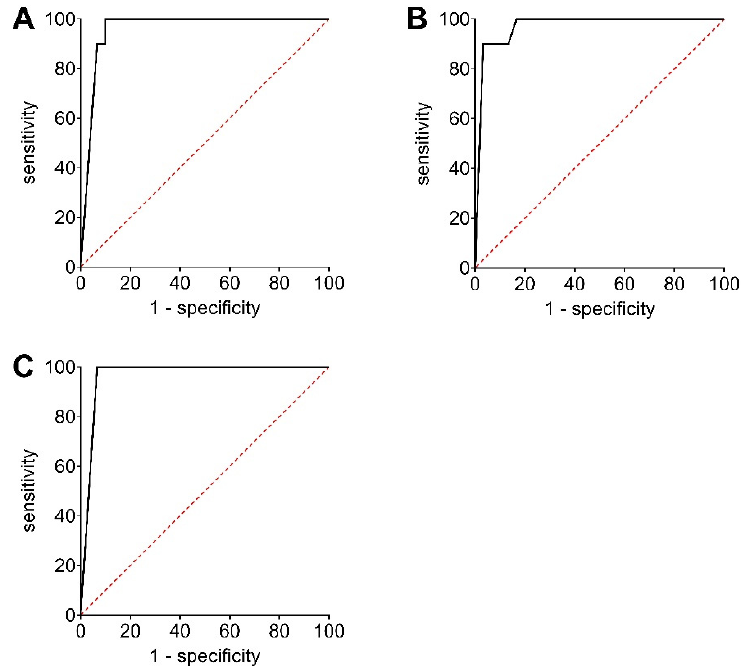
Figure 1. Receiver operating curve (ROC) analyses illustrating the relation of sensitivity and 1-specificity of CDV-Mix 3 ( A ), CDV-Mix 7 ( B ) and ELIA Mix ( C ).